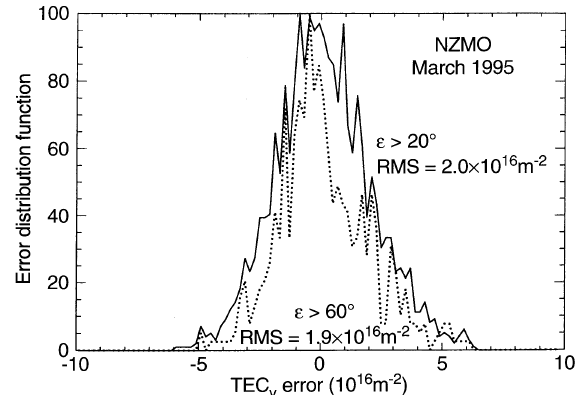
Fig. 4. TEC reconstruction error distribution function for differ- ences between TEC-map values and TEC values measured by the GPS station Neustrelitz which does not contribute to the TEC maps. The analysis includes approximately 2000 — 3000 data points from March